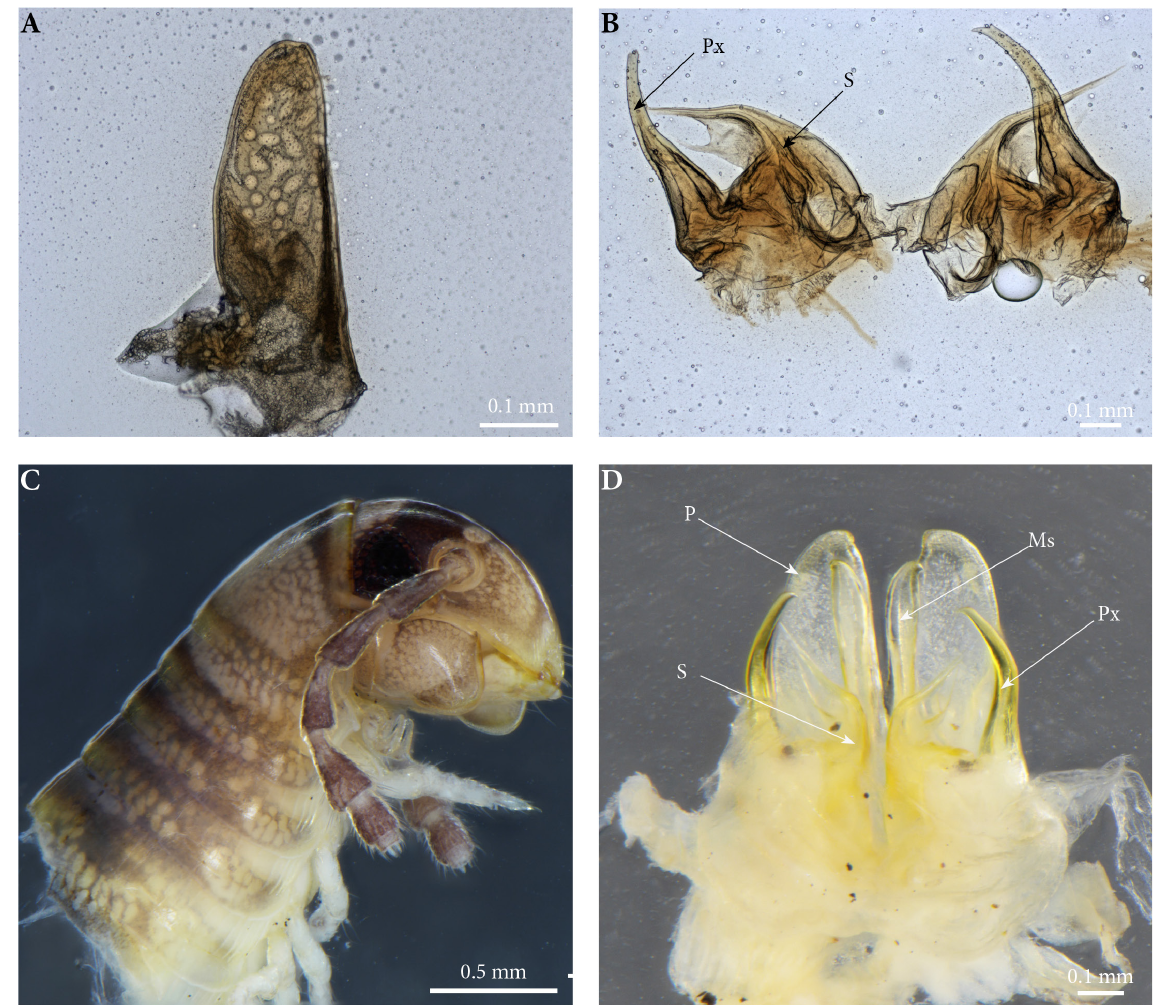
Fig. 18. Ommatoiulus porathi (Verhoeff, 1893). A–B . Holotype ♂, Verhoeff’s slide preparation 1190, (ZMB). A . Right promerite, posterior view. B . Posterior gonopods. C–D . ♂ from Viseu, (NHMW 8736). C . Head and anterior rings, lateral view. D . Gonopods, posterior